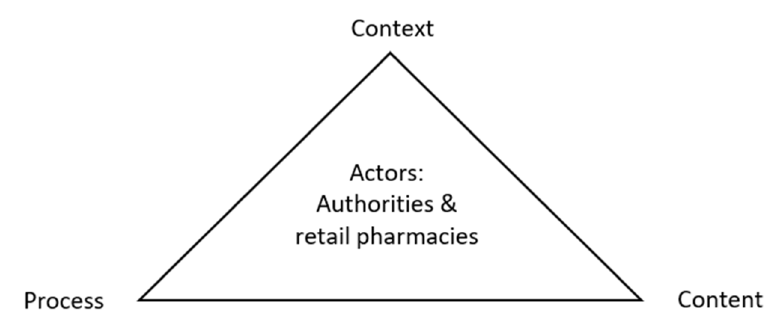
Figure 2. Health policy analysis triangle.